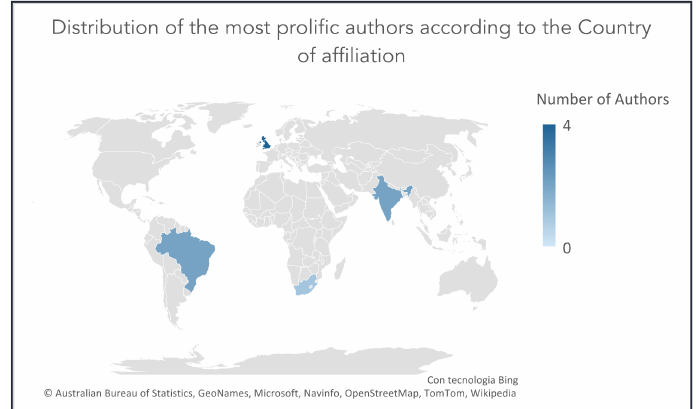
Figure 6. Distribution of the most prolific authors according to the country of affiliation.